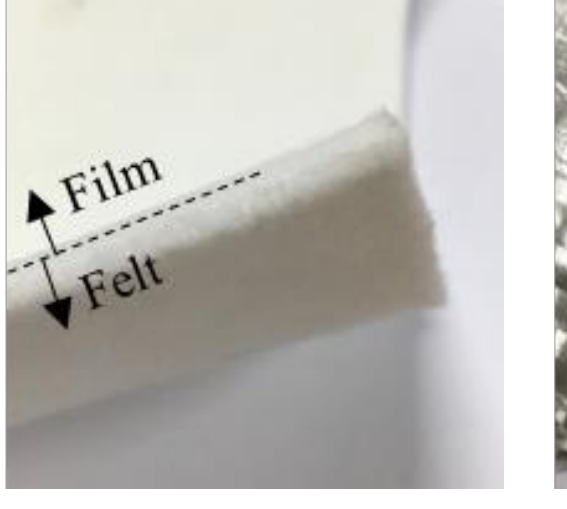
Table 2. Summary of materials and its characteristics for CIPP liner.